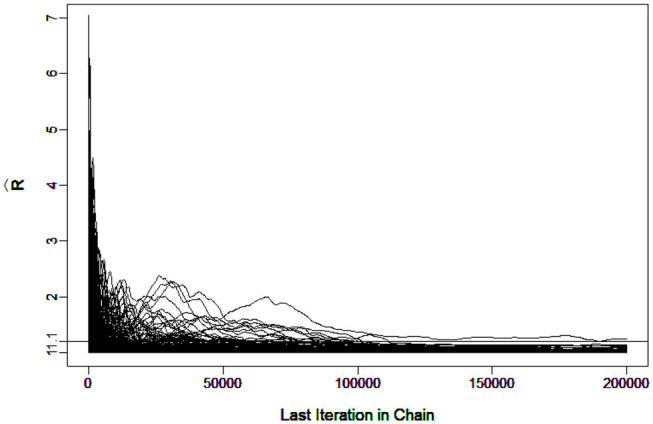
Trace Plots of R^ for the real data in the GDINA model.